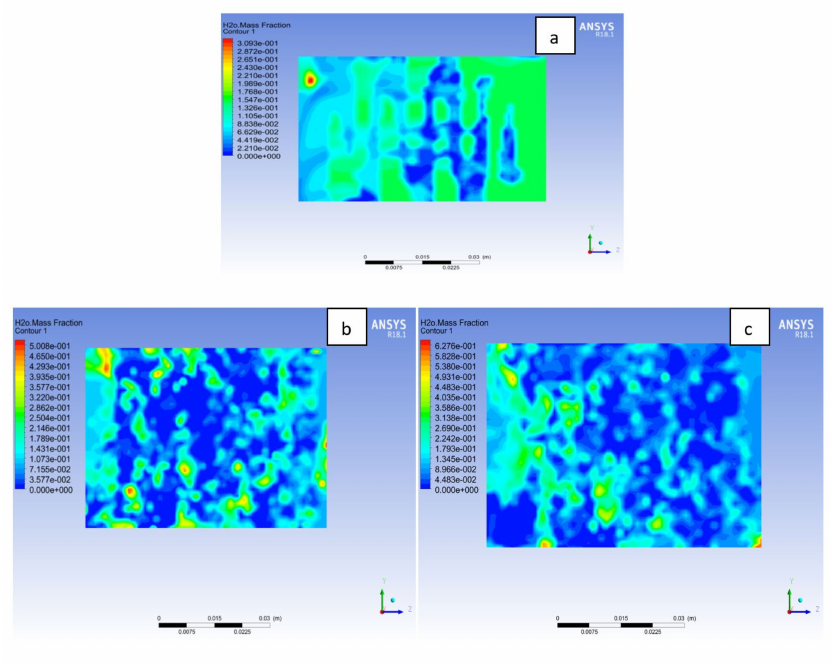
Figure 18. Water mass fraction at the membrane for ( a ) Aluminum, ( b ) Copper, ( c ) Steel bipolar plate materials at 338 K, 1.5 bar.